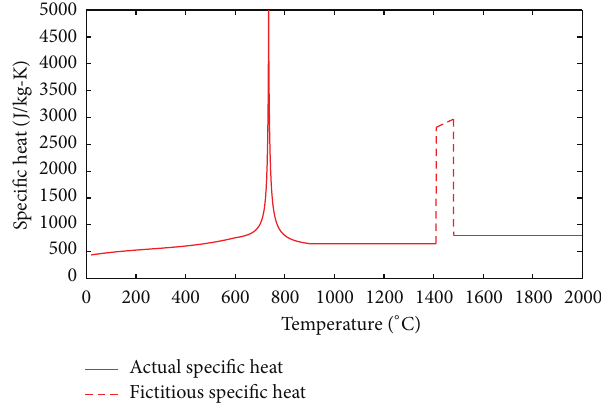
Figure 3: Apparent variation of specific heat with temperature.